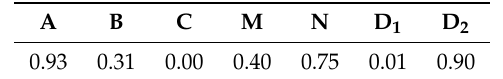
Table 2. JH-2 calibrated material properties values for gres.